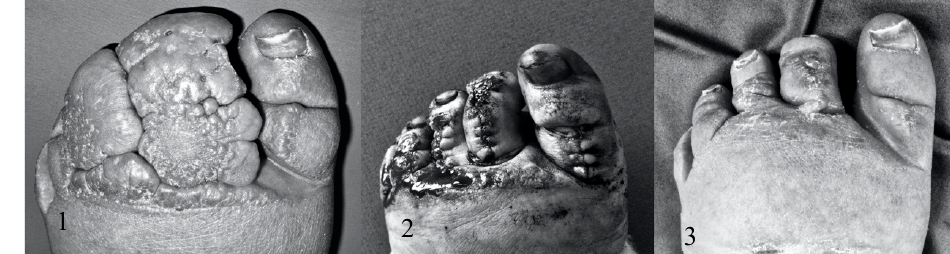
Figure 3. Procedure of excision and reconstruction in FOXC2 lymphedema: ( 1 ) preoperatively; ( 2 ) after 1 week and ( 3 ) after 12 weeks.